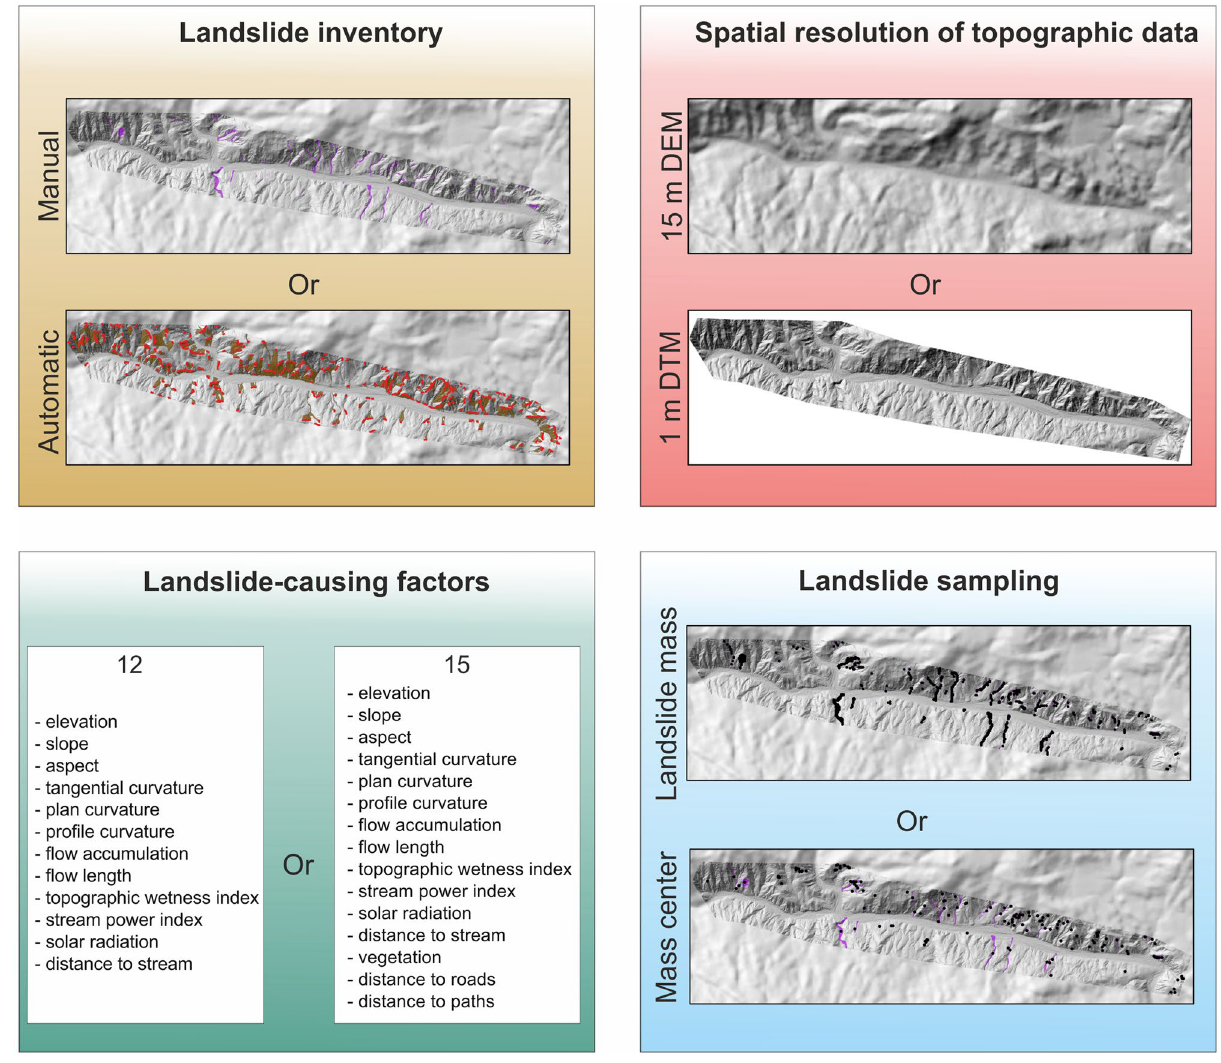
Figure 4. Differences in input data included in landslide susceptibility modeling using the logistic regression method for two selected study regions in the Coyuca River basin in SW Mexico. Maps were generated using ArcMap 10.2.2 software, copyright and licensed by ESRI (http:// deskt op. arcgis. com/ en/). The final layout was created in CorelDRAW 2018 (https:// www. corel draw. com/